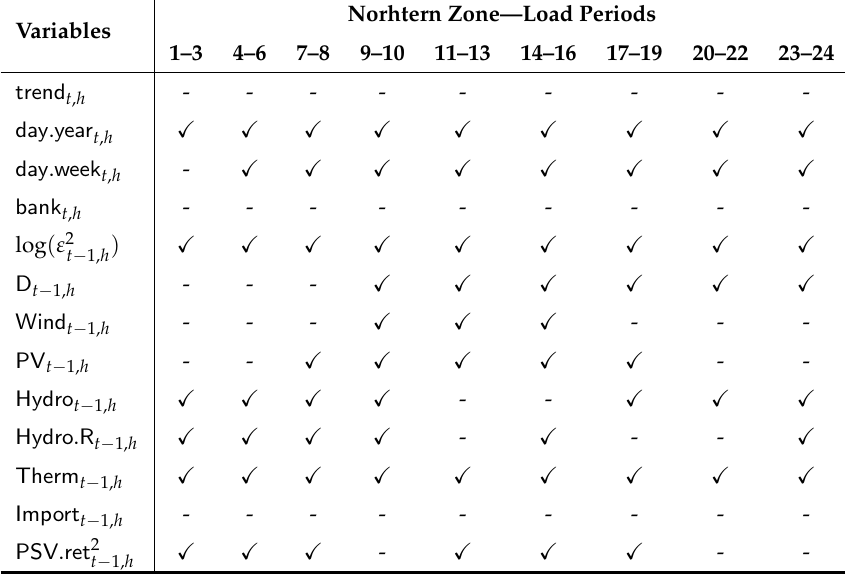
Table 3. Selected variables for the predictive models for the conditional variance of price in the northern